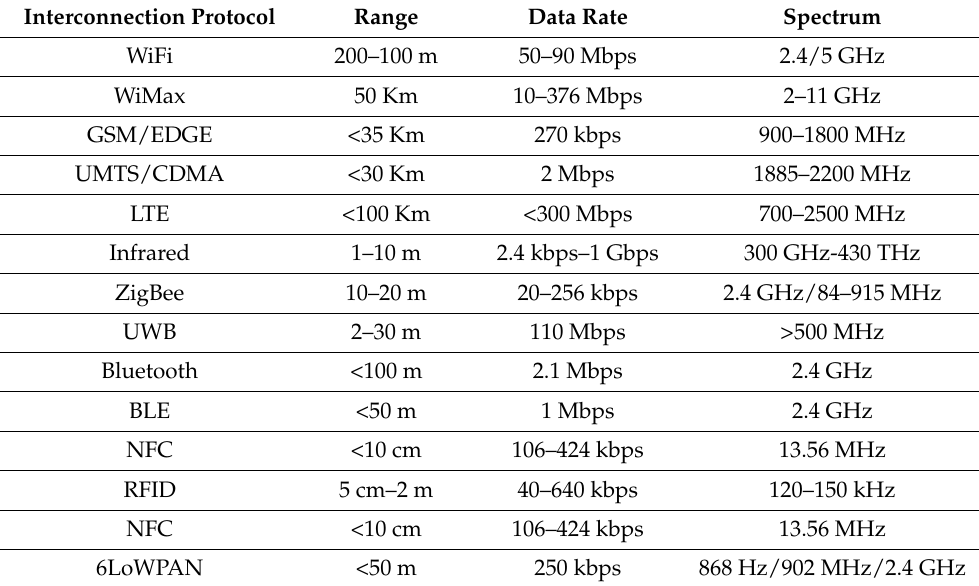
Table 3. Overview of interconnection technologies commonly used in IoHT devices, partially obtained from [19,47,48,73,74]. Interconnection